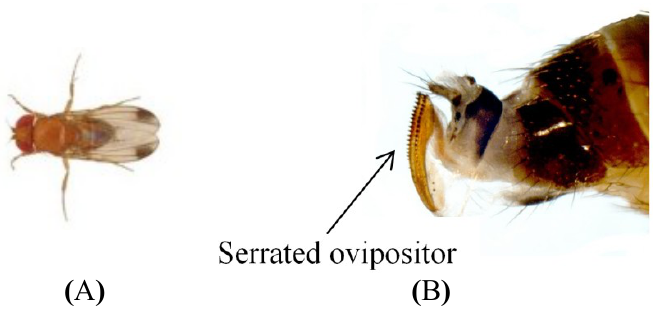
Figure 1. ( A ) Adult male Drosophila suzukii (UK Crown Copyright © ); ( B ) Female serrated ovipositor (Martin Hauser Phycus ©